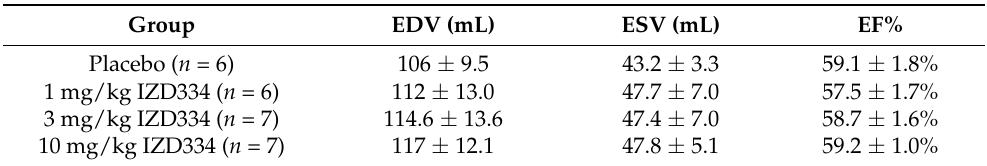
Figure A1. Regional cardiac function and dobutamine echocardiography in animals treated with placebo or 10 mg/kg IZD334. ( A ) Septal and inferolateral systolic wall thickening; SWT (%) at base- line and 7 days after MI with or without dobutamine. ( B ) Systolic wall thickness; WT (cm) ( n = 5 – 7).